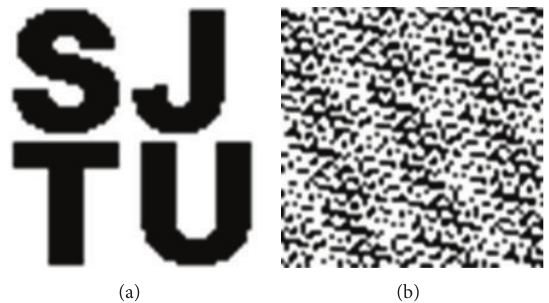
Figure 5: Images before and after Arnold transform.